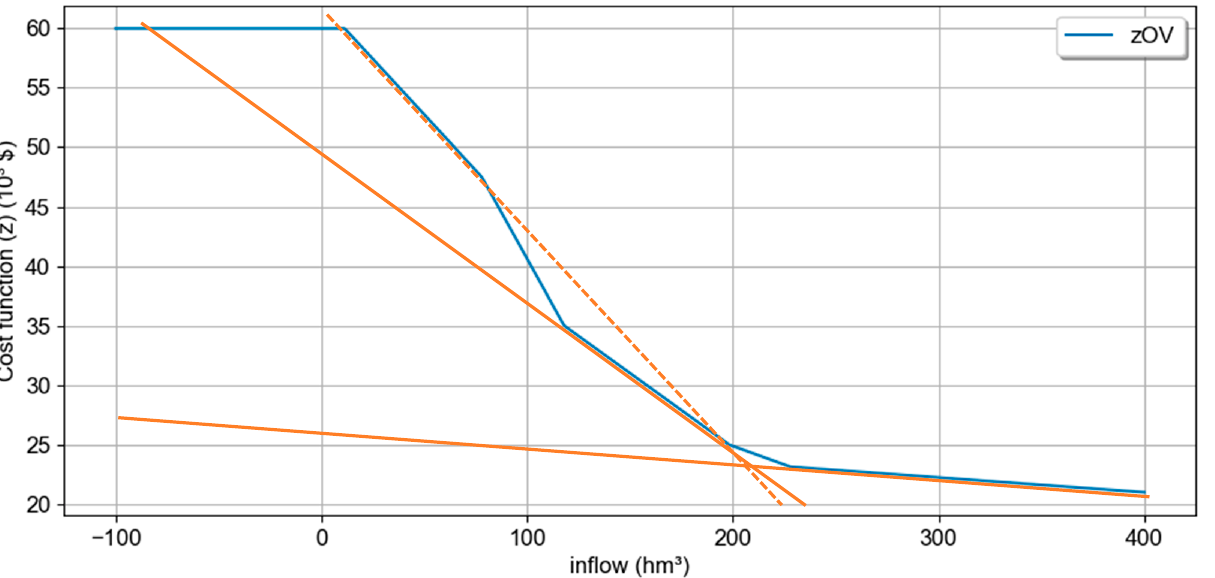
Figure 3. Cost function ( 𝑧 ) (10 3 $) per initial volume (hm 3 ) and initial inflow (hm 3 ). (cid:3016)(cid:3023)